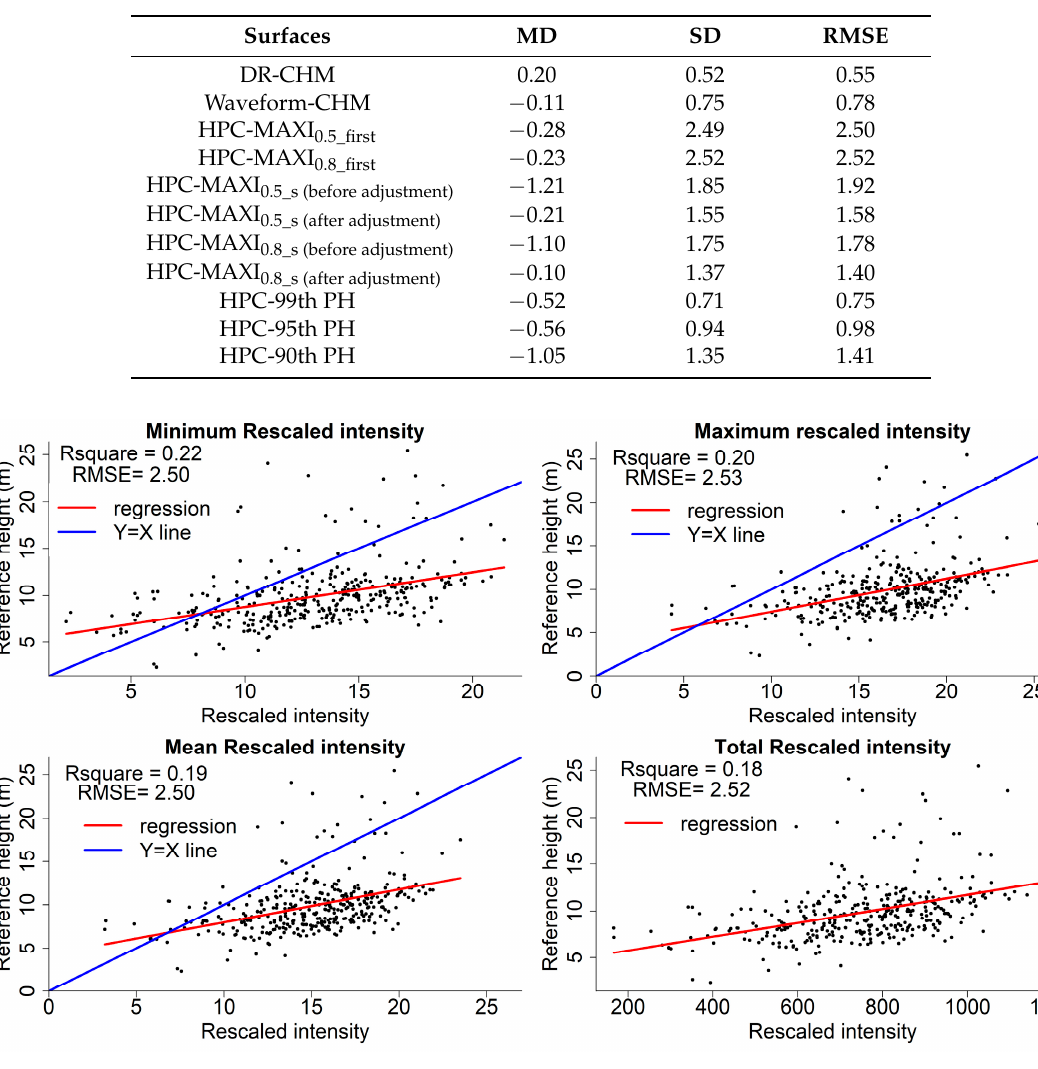
Figure 10. The linear relationship between reference tree height and mean rescaled intensity (minimum, maximum, mean and total rescaled intensities) within the 2.5 m buffer of the waveform intensity surface (WIS, 0.5 m resolution).